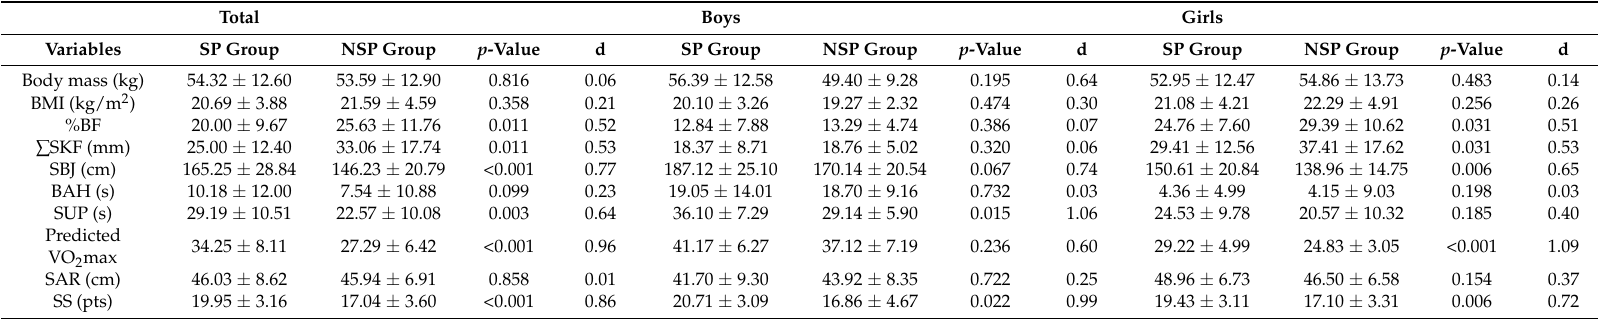
Table 2. Mean and standard deviation of body composition and physical fitness differences between adolescents from sport participation and non-sport participation groups by